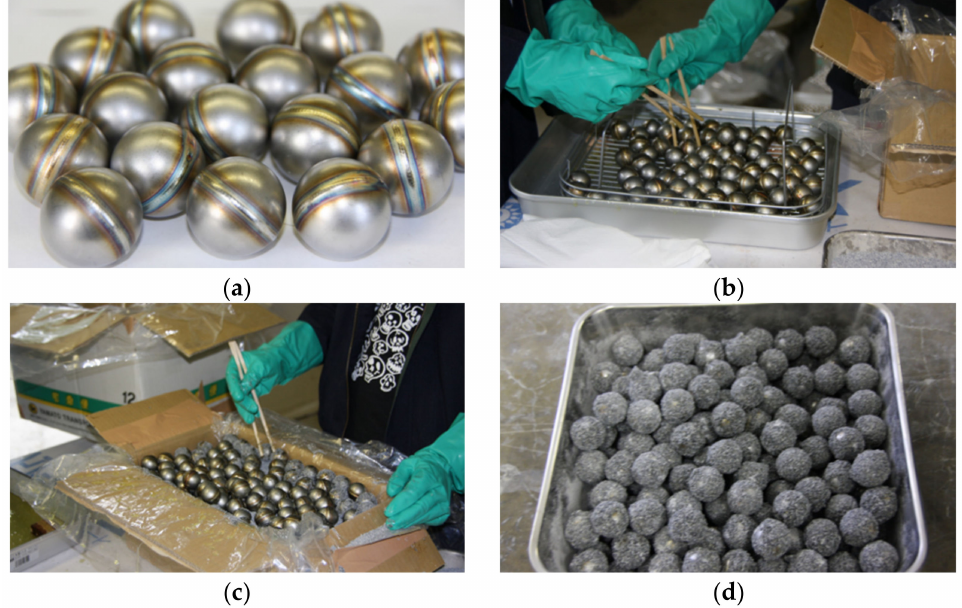
Figure 7. Coating stainless steel spheres using sand grains. ( a ) Stainless steel spheres. ( b ) Coating with epoxy resin. ( c ) Coating with sand grains. ( d ) Sand-coated stainless steel